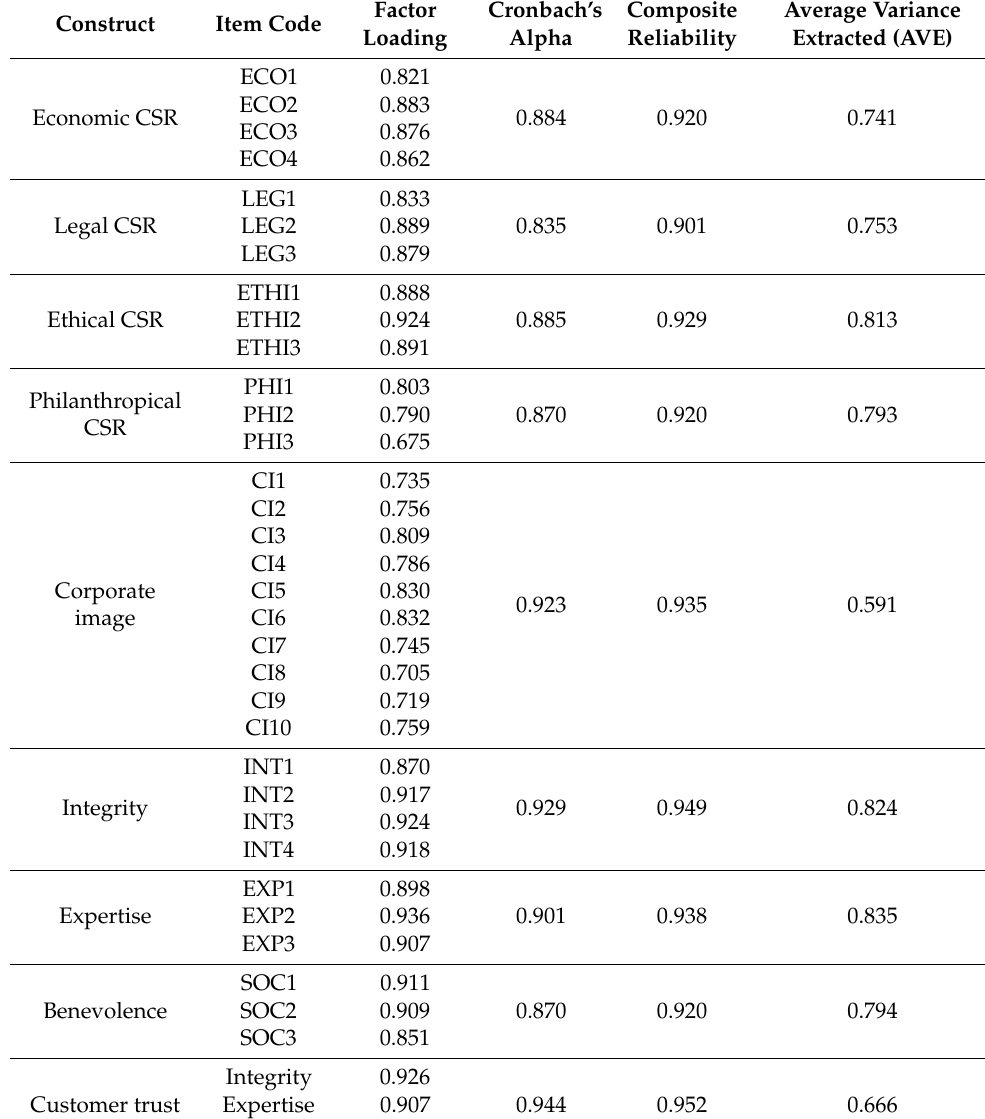
Table 1. Convergent